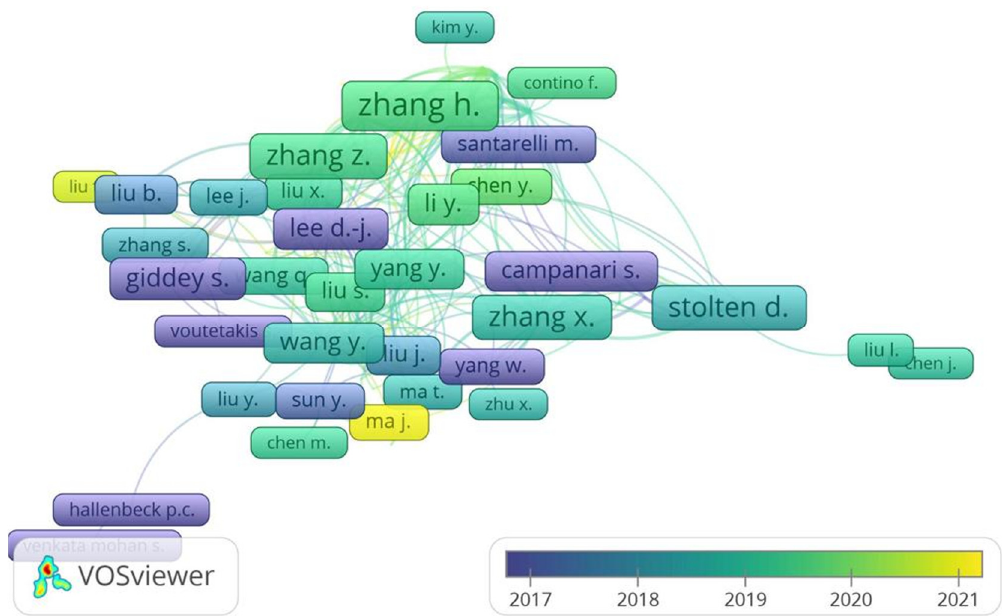
Figure 7. Tree fields plot illustrating the relationship between authors, keywords, and journals.